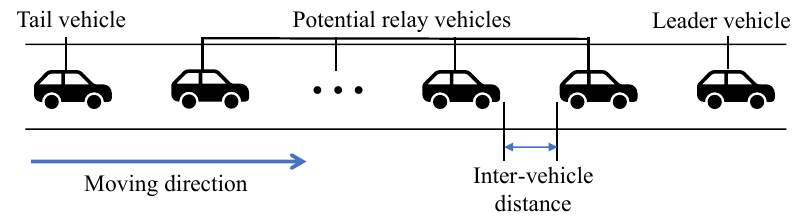
Figure 1. Topology of the platoon-based driving in